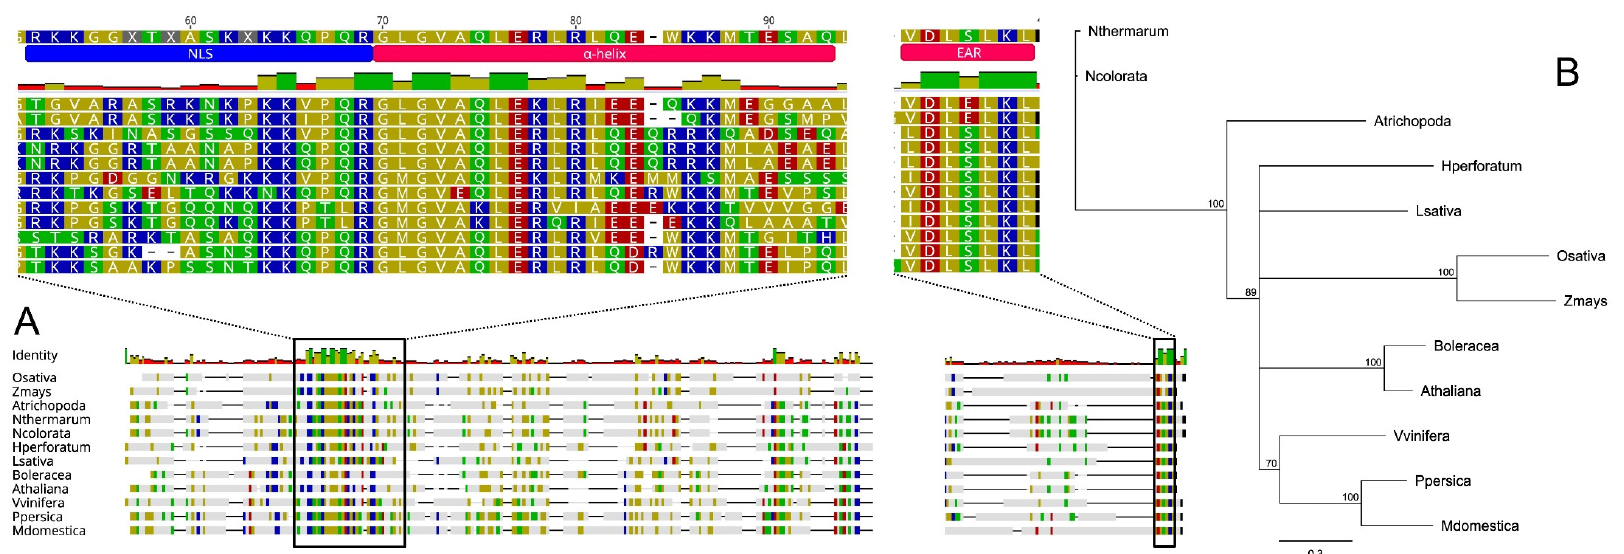
Figure 2. Bioinformatic analysis of the SPL / NZZ gene homologs in plant species representing the two major groups of angiosperms, monocotyledons and dicotyledons, including different basal angiosperm lineages belonging to the families Amborellaceae and Nymphaeaceae. ( A ) MUSCLE-based amino acid alignment of 11 putative SPL / NOZZLE sequences retrieved from Zea mays (KY110964.1), Oryza sativa (LOC_Os01g11430.1), Hypericum perforatum (apomictic species, OBUPD-D1 Hpctg51499), Brassica oleracea (Bol013057), Malus domestica (MD11G1234600), Prunus persica (Prupe.4G192500.1), Vitis vinifera (VIT_219s0014g03940.1), Lactuca sativa (Lsat_1_v5_gn_0_5400), Amborella trichopoda (XP_006833114.1), Nymphaea colorata (XP031473161.1), Nymphaea thermarum (KAF3782288.1), putative orthologues of SPL protein of Arabidopsis thaliana (AT4G27330). On the top of the panel the three main functional domains that resulted conserved among the 12 proteins are highlighted. NLS is a basic region rich in Arginine (R) and Lysine (K) that is thought to represent a putative nuclear localization signal; the α -helix sequence (also known as SPL-motif) is crucial for the constitution of homodimers and heterodimers, binding and inhibiting CINCINNATA (CIN)-like TEOSINTE BRANCHED1 / CYCLOIDEA / PCF (TCP) transcription factors (TF); the EAR motif in the C-terminal region recruits TOPLESS / TOPLESS-RELATED (TPL / TPR) proteins to co-suppress the activity of the CIN-like TCP family. ( B ) Similarity-based neighbor-joining analysis performed using the 12 amino acid sequences with bootstrap values supporting all major